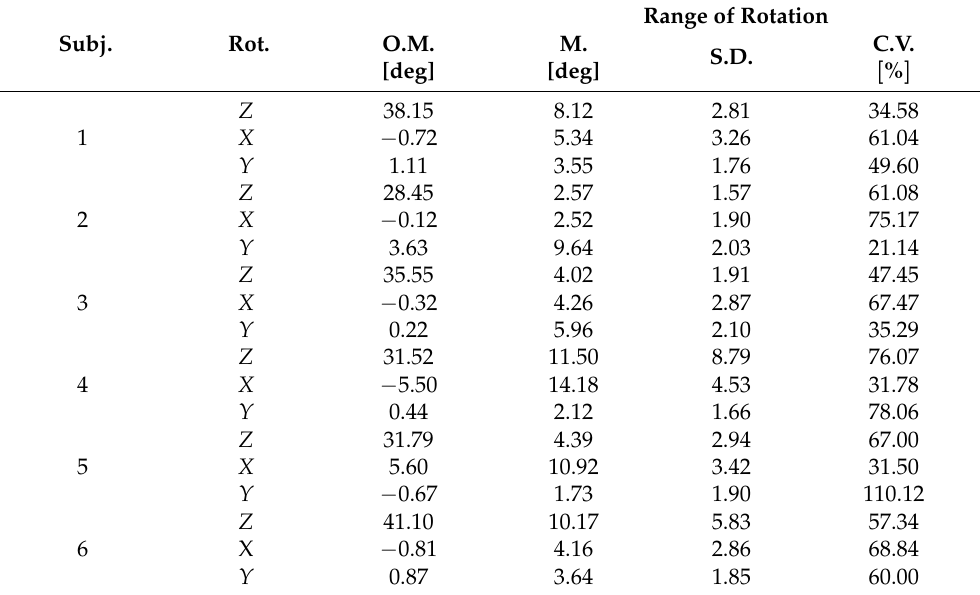
Table 3. Descriptive statistics of the difference of rotation. The overall mean presents the average value of each rotation for all the gait cycles. The rotation range is the difference between the maximum and minimum value for the each rotation’s mean curve. Units in degrees. (O.M.: Overall mean, M.: Mean, S.D.: Standard Deviation, C.V.: Coefficient of